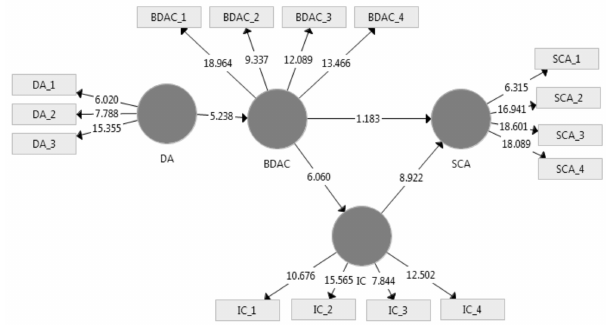
Figure A2. Model fit estimation using bootstrapping